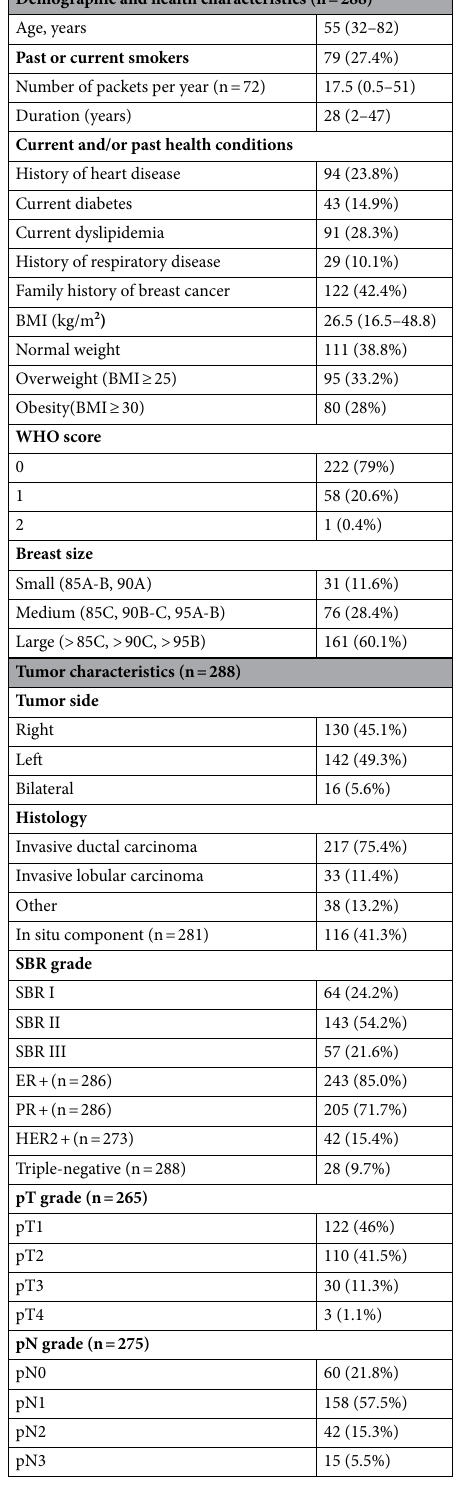
Table 2. Characteristics of the study population and the tumors on inclusion. Data are quoted as the number (percentage) or the median (range). WHO World Health Organization, BMI body mass index, SBR Scarff- Bloom and